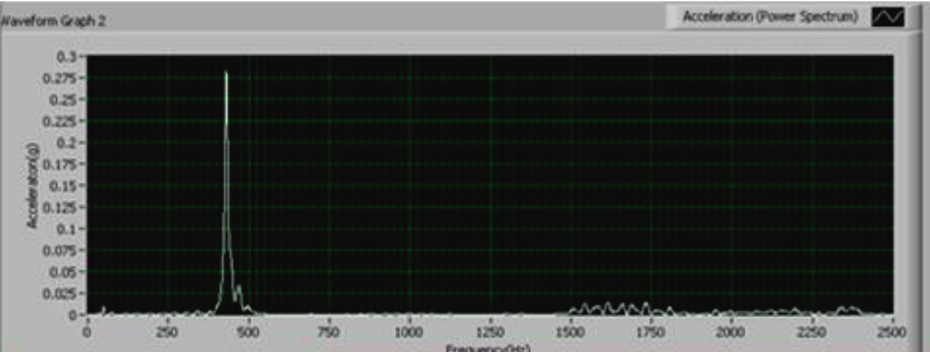
Figure 11: Frequency response of Mg alloy swivel plate under loading condition (4kg). Table 7: Frequency under loading condition for A3 steel (with 4 location points). S.